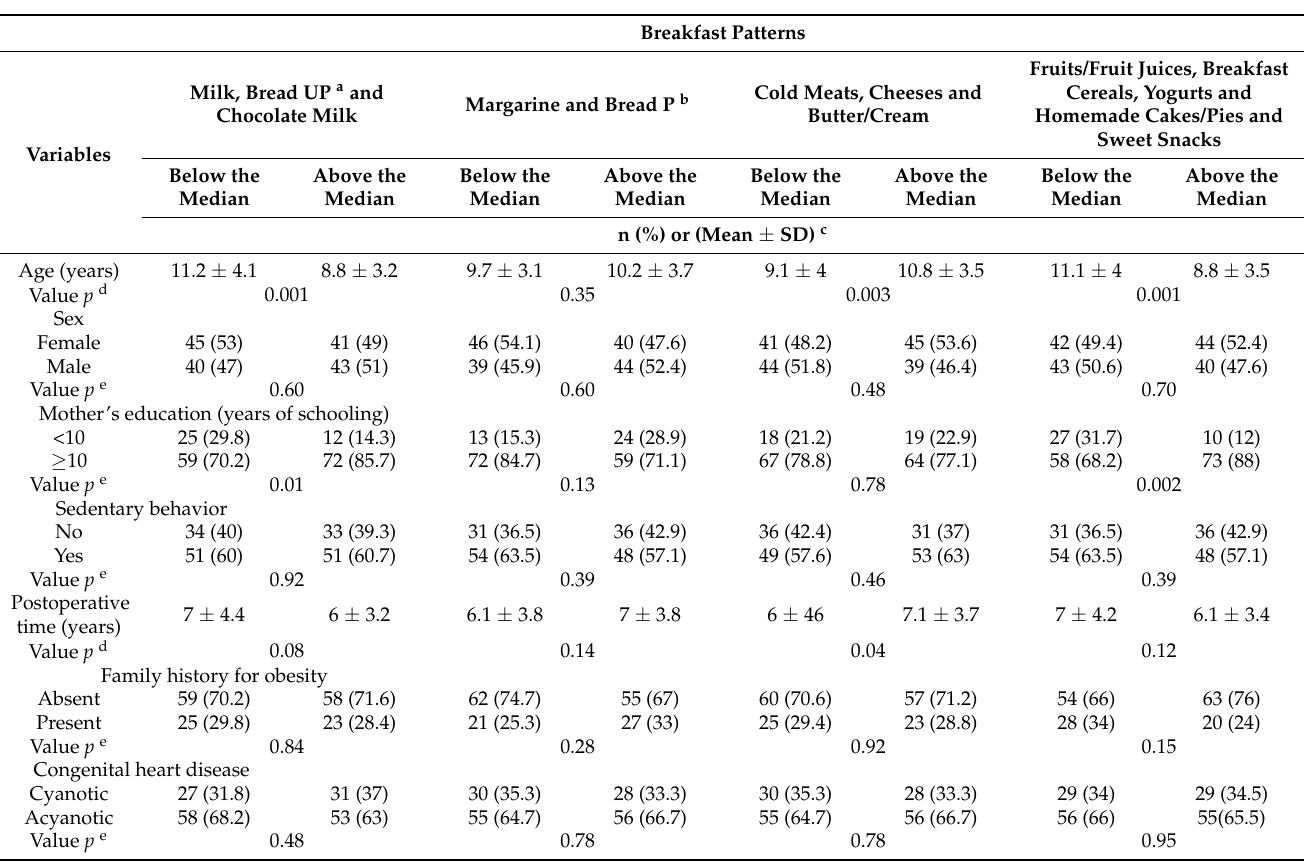
Table 4. Sociodemographic, clinical and lifestyle data of a cross-sectional study with 169 children and adolescents with CHD according to the classification of below and above the median of each breakfast pattern. Brazil (2017).